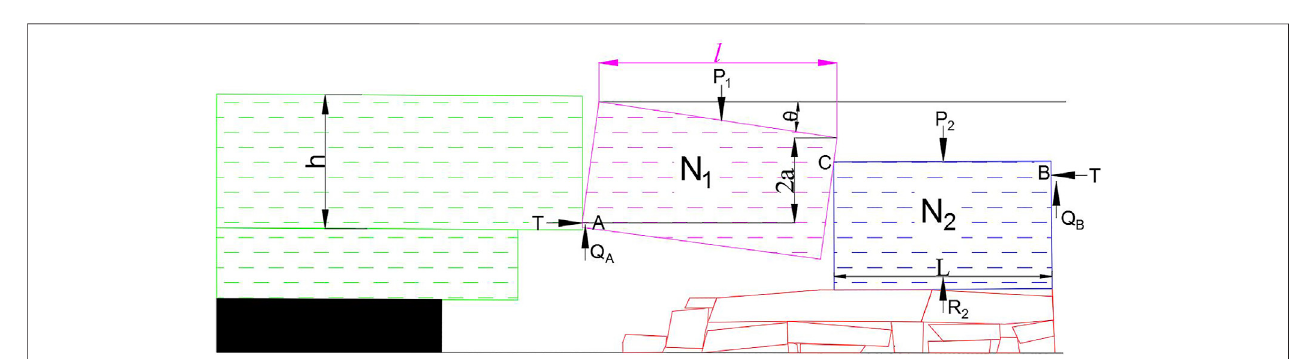
FIGURE 9 | Failure mode and mechanics model of overlying